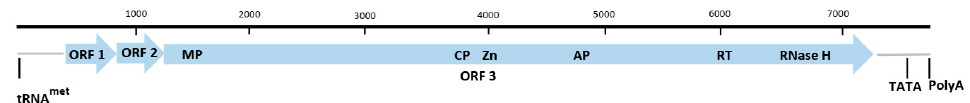
Figure 4. Schematic representation for the linearised genome organization of members of the genus Badnavirus , family Caulimoviridae. ORF1 encodes P1 protein (function unknown), ORF2 encodes P2 virion-associated capsid protein (nucleic acid binding activity), ORF3 encodes polyprotein P3 (VMP, CP, AP, RT, RNase H1). tRNA met binding site designated as the origin of the circular genome. Badnavirus-like particles were first reported from yam in association with a potyvirus causing internal brown spot disease in D. alata and D. cayenensis-rotundata complex in the Caribbean in the 1970s [81,82]. Subsequently, badnaviruses in other Dioscorea spp. were